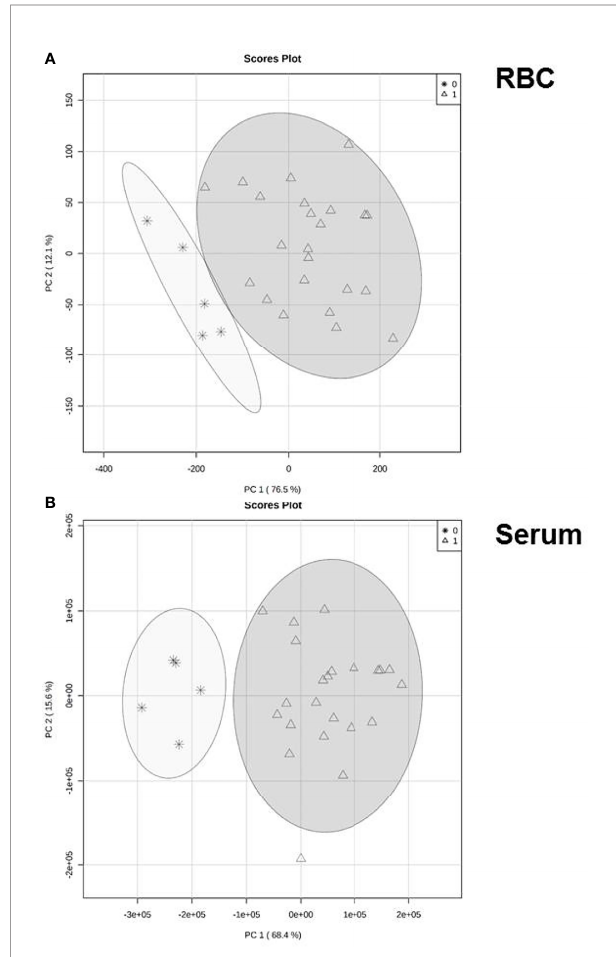
FIGURE 2 | Reprogramming of ceramide generation. Variation of ceramide pro fi le either in RBC (A) or serum (B) in patients with COVID-19 compared to healthy volunteers. Principal component analysis (PCA) based on concentration pro fi le of six ceramide specimen (16:0, 18:0, 20:0, 22:0, 24:0, 24:1) that passed the quality screen. Each circle represents the centroid of all samples in the representative group at day 1 of intensive care of COVID-19 patients). Healthy controls are given as asterisks, patients in